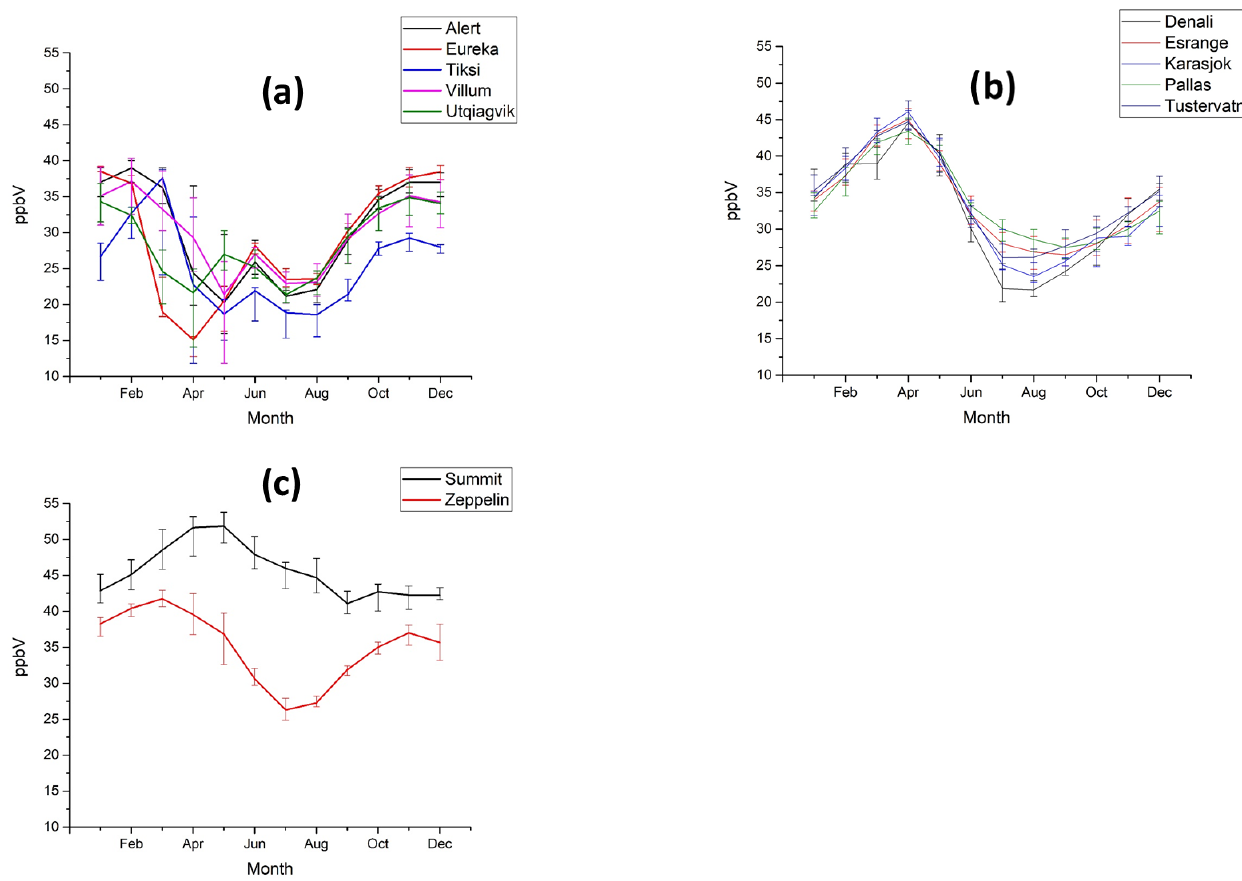
Figure 5. Seasonal behavior of surface O 3 at selected Arctic stations that are representative of sites in the (a) coastal high Arctic, (b) near the Arctic Circle, and (c) at high elevation. Monthly medians are calculated for the period 2003 to 2018. Data were not available from 2003 to 2006 for Villum or 2004 and 2013–2015 for Alert. Data from Tiksi were available for the period 2013–2018, and at Karasjok the measurements stopped in 2010. The error bars show upper (75%) and lower (25%)